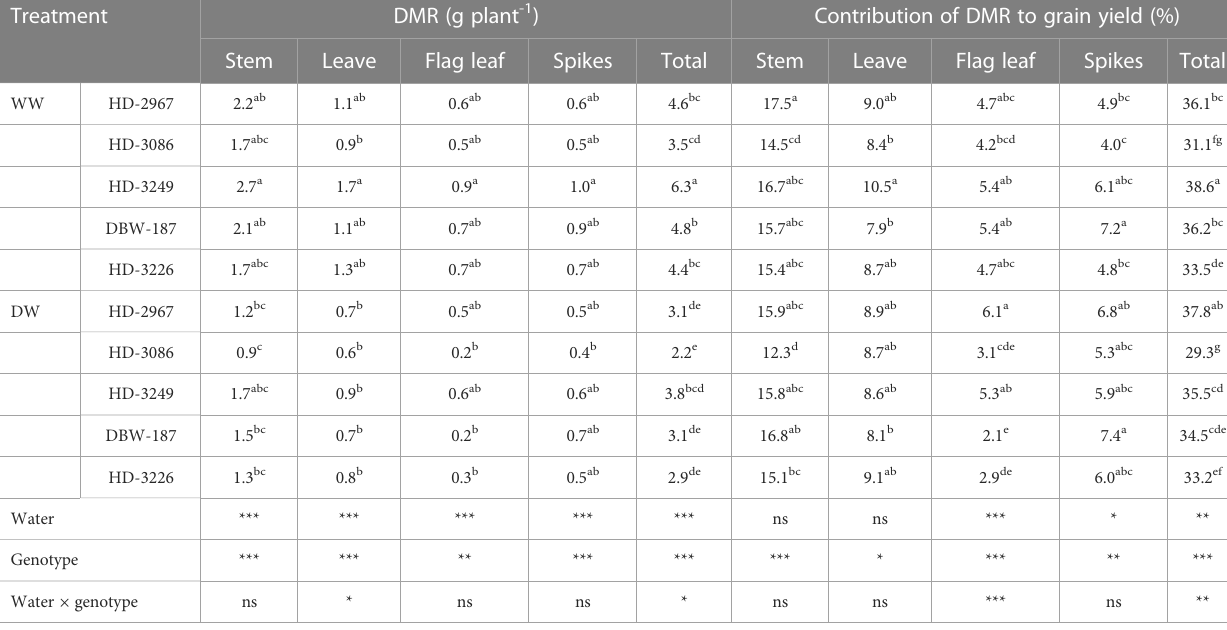
TABLE 3 Dry matter remobilisation of the vegetative organs and contribution to grain dry weight of wheat genotypes grown under well- and de fi cit- watered conditions.